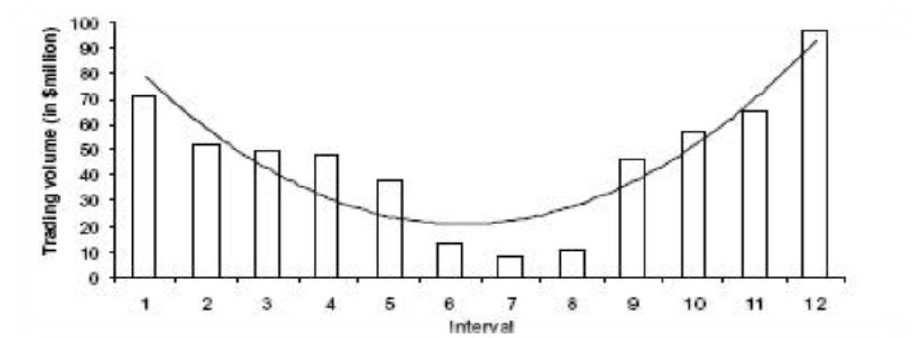
Figure 3. The Histogram for the Volume during One Trading Day